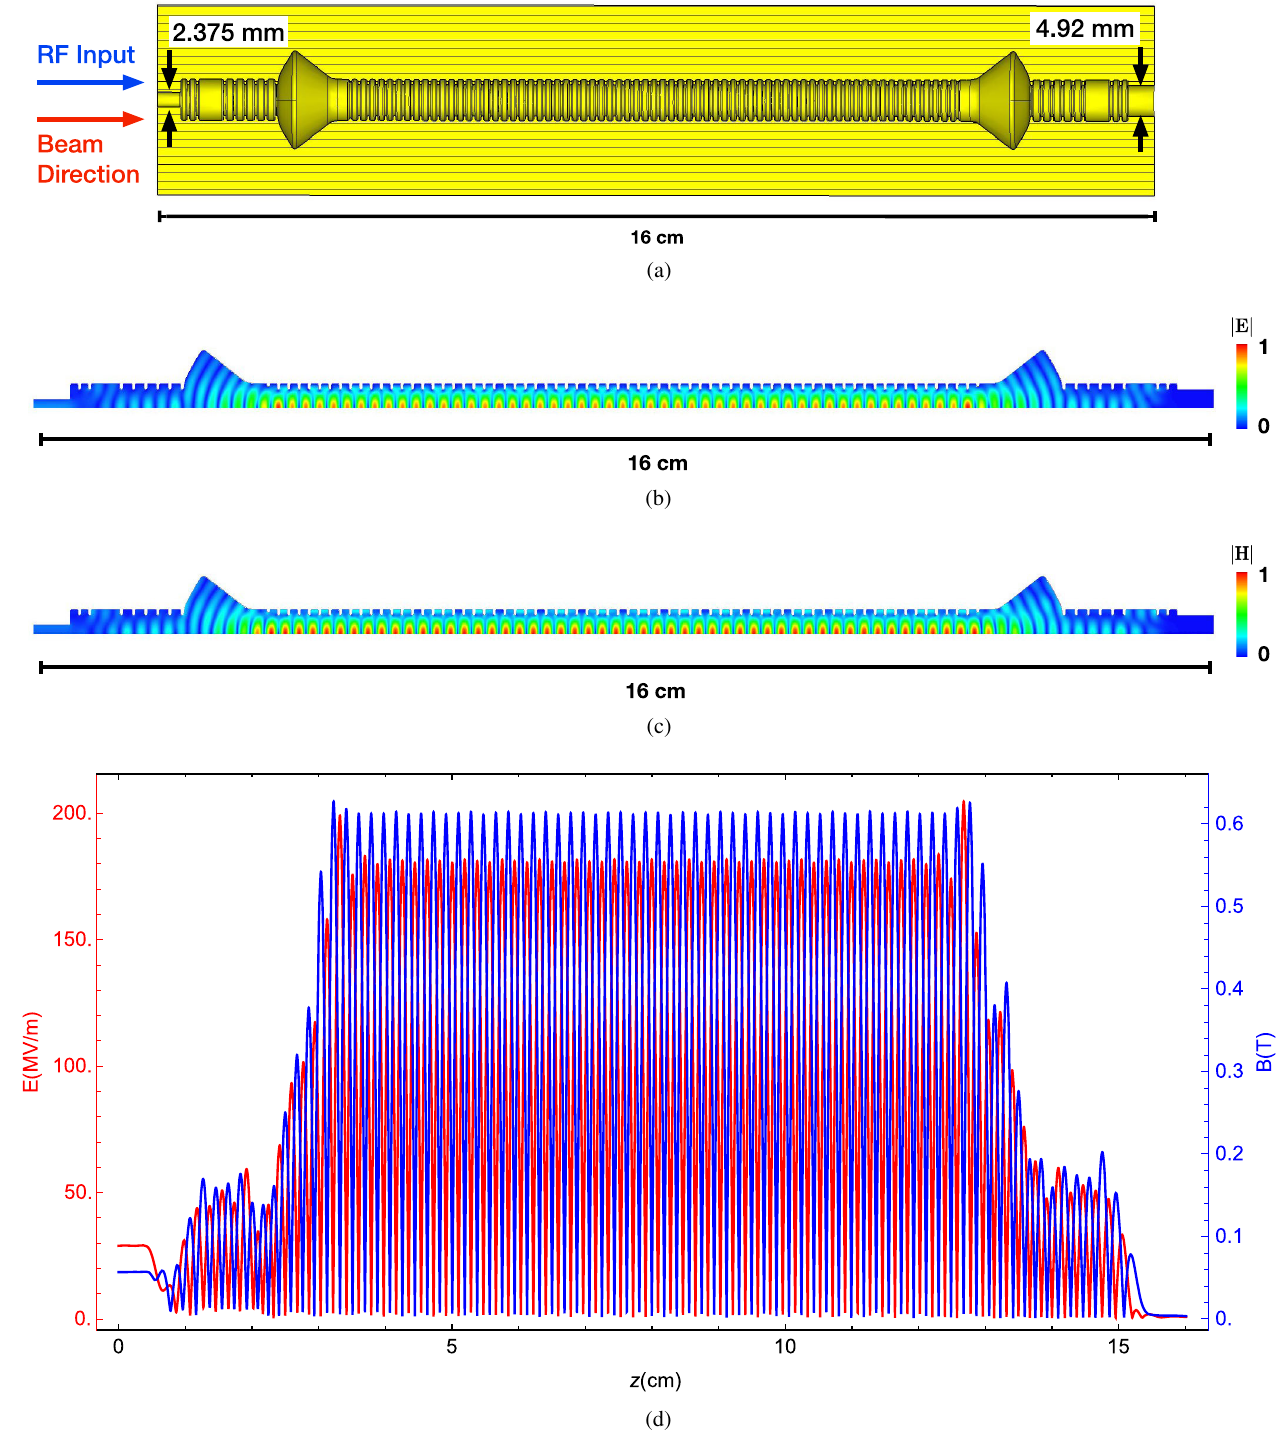
FIG. 11. Undulator cavity, adapted from Toufexis et al. [22]. (a) Metallic surface, (b) electric field profile, (c) magnetic field profile, and (d) Undulator cavity on-axis field